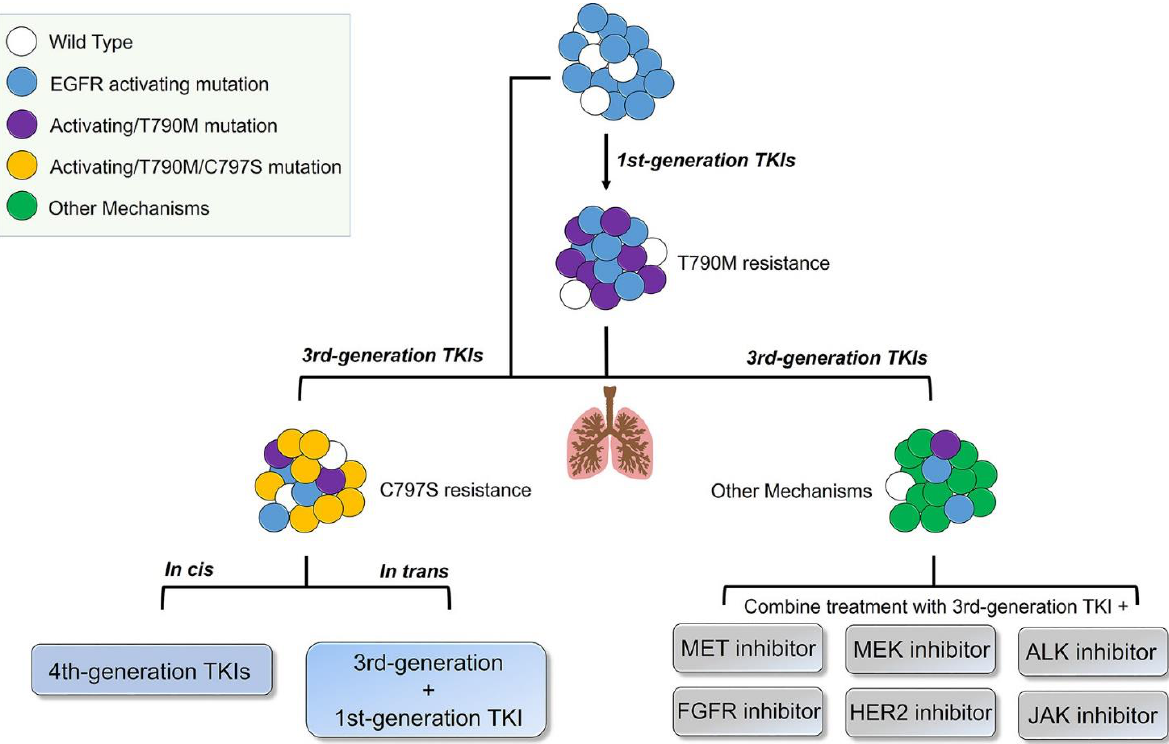
Figure 6. Comprehensive post-therapeutic strategies of drug resistance for EGFR mutant NSCLC-targeted therapy. The colored ball represents acquired resistance mechanism, which indicates the heterogeneity of tumor (JAK: Janus-activated kinase). Reprinted with permission from ref. [115]. Copyright 2018 ACS American Chemical Society.